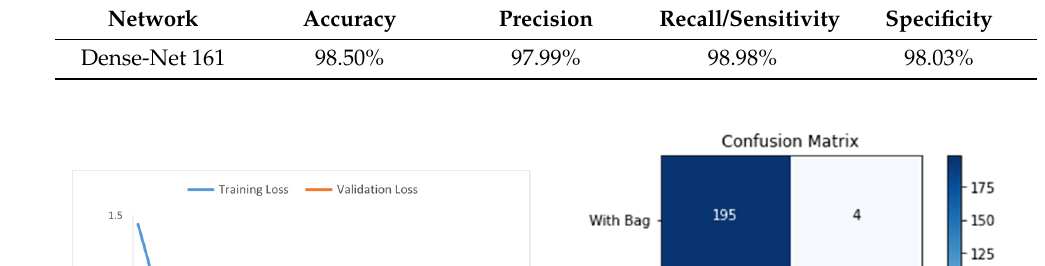
Table 5. The evaluation results on the PETA dataset.